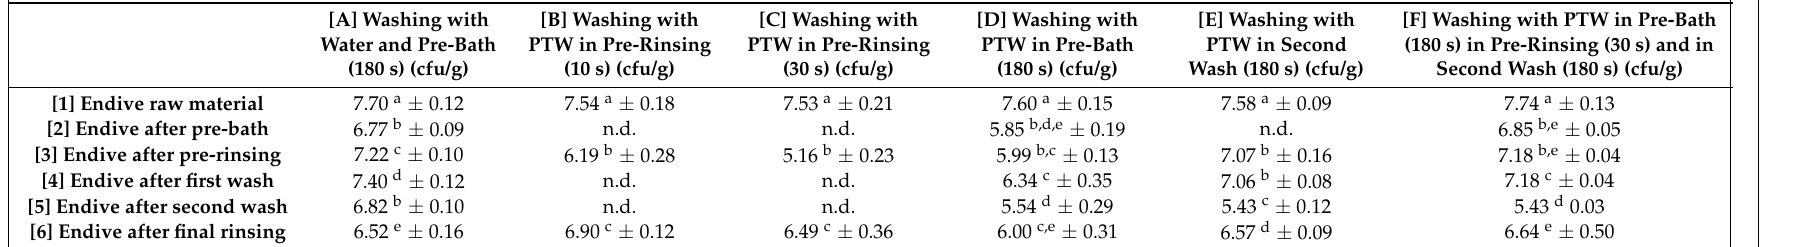
Table 1. Total viable count on endive lettuce after washing with or without the addition of plasma-treated water (PTW) at different processing steps. Letters and numbers in square brackets refer to the six trials and six sampling points, respectively, described in Section 2.2.